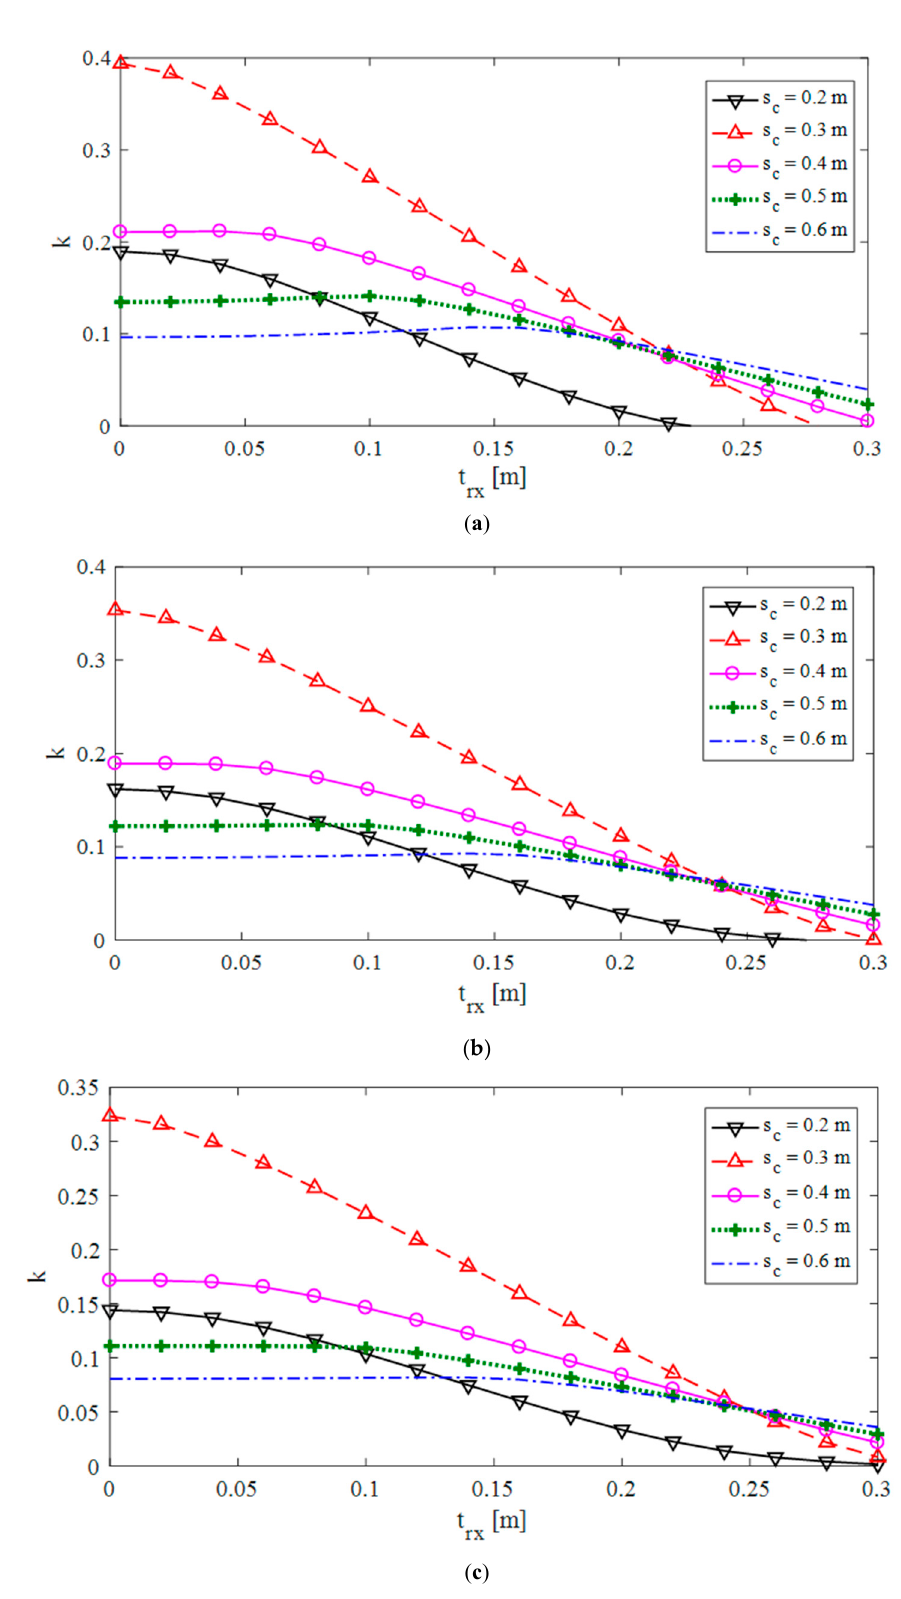
Figure 8. Coupling factor k vs. lateral misalignment t rx along x -axis for square coil, for different landing gear height: hs = 0.1 m ( a ), hs = 0.15 m ( b ) and hs = 0.2 m ( c ).